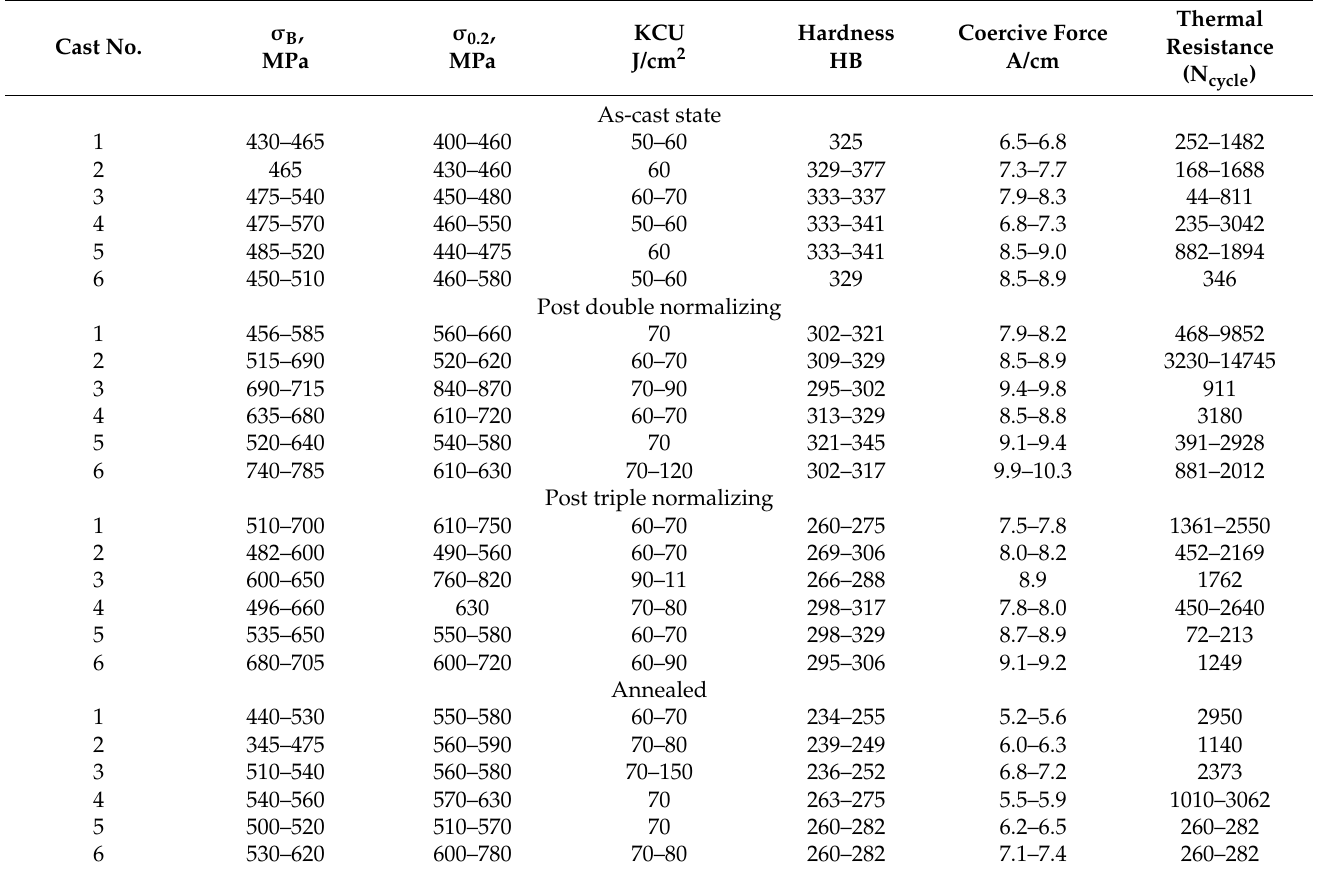
Table 3. Mechanical, physical properties and coercive force ( Н с ) of the hypereutectoid steel after cast and heat treatment.